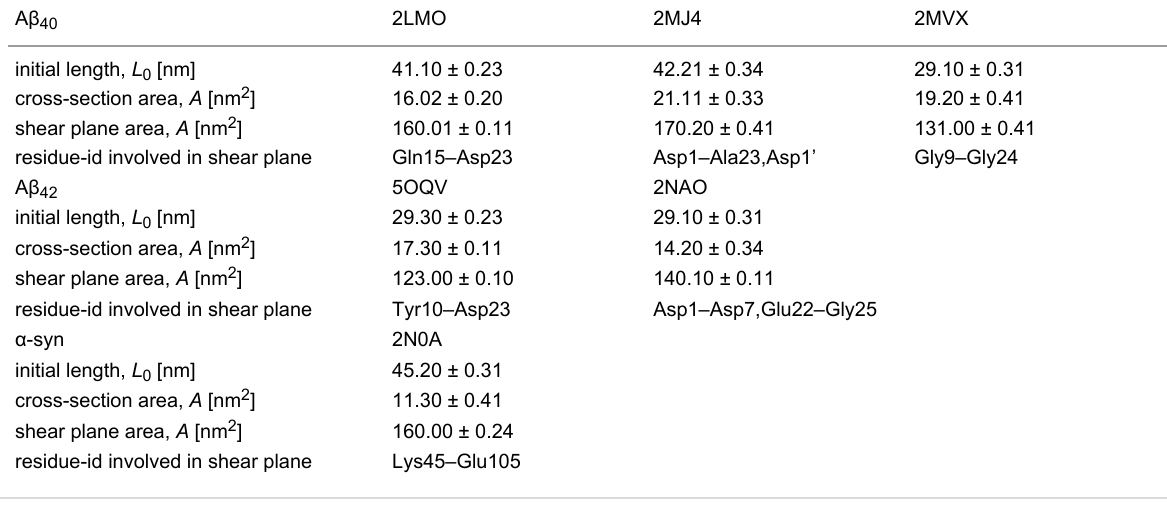
Table 1: List of geometric parameters of the fibril structures used to determine the Y L , Y T , and S . The last line of each fibril entry gives the protein segment used to define the shear plane as illustrated in Figure 3.